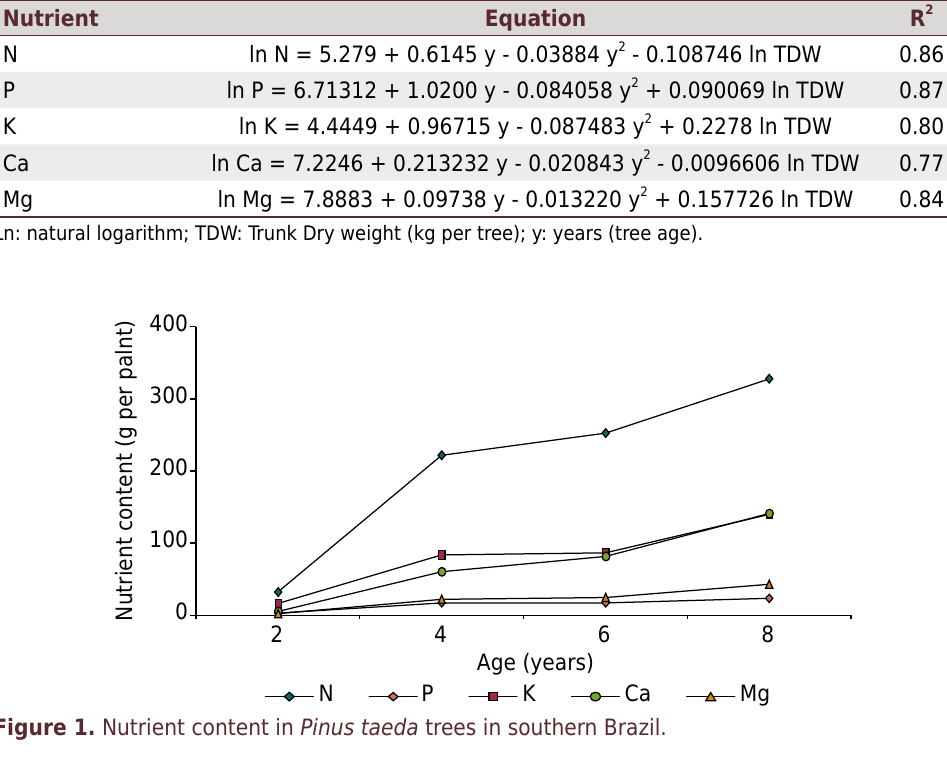
Table 6. Equations to estimate the nutrient use efficiency in the trunk of P. taeda trees in southern Brazil Nutrient